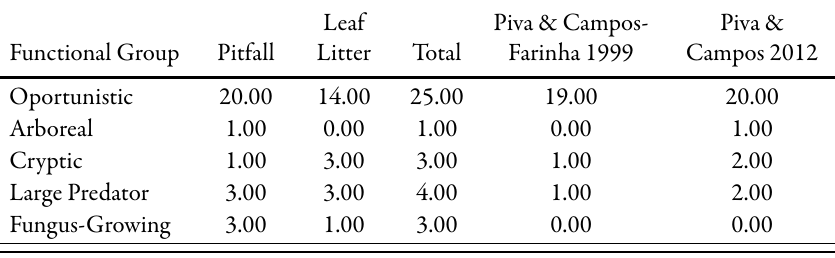
Table 3. Comparison of functional group species richness (number of species) among the two sampling methods to survey ants and data from Piva &Campos-Farinha (1999) and Piva & Campos (2012) in Vila Mariana neighborhood, São Paulo, Brazil.